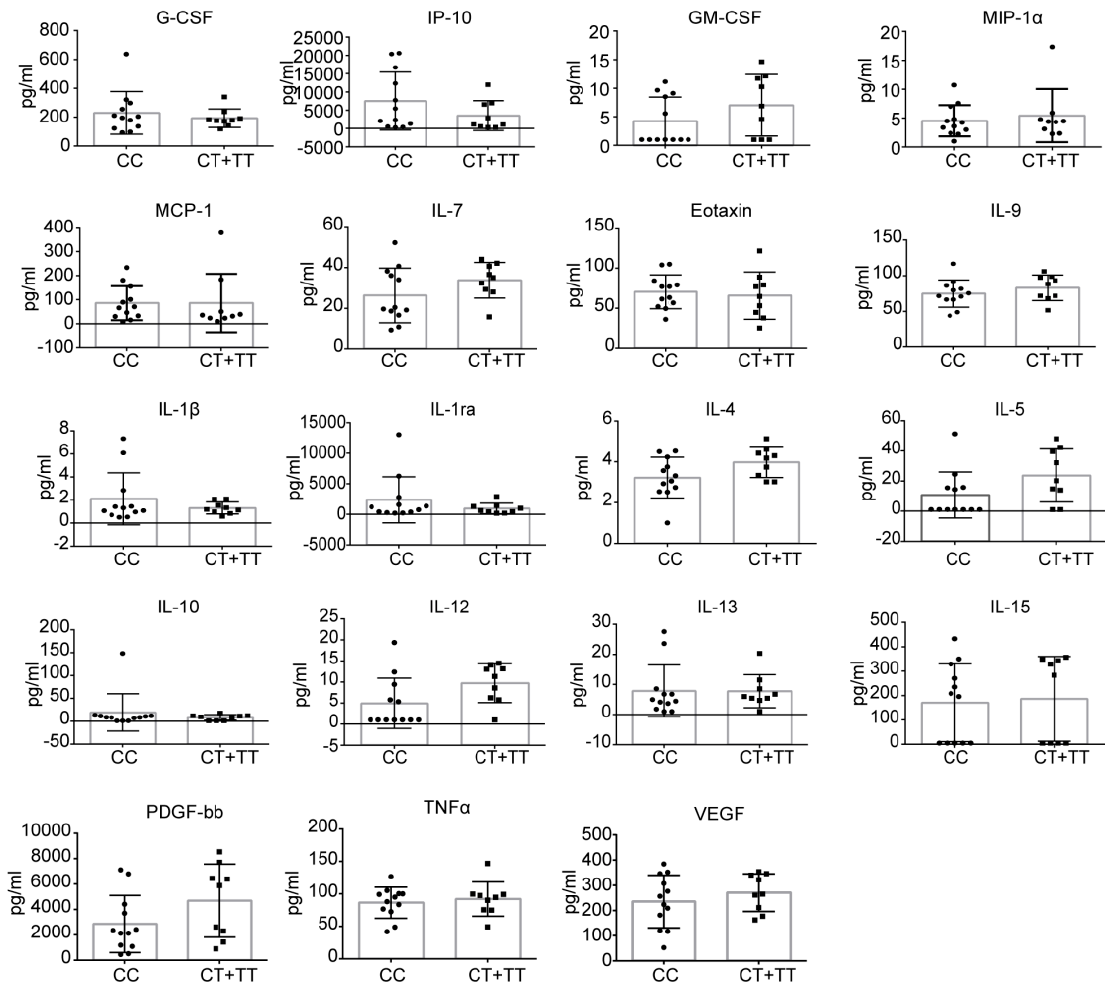
Figure 5. Levels of cytokines and chemokines in COVID-19 patients with the CC genotype or the CT/TT genotypes. Statistically significant differences were observed for IL-2 ( p = 0.043), IL-17 ( p = 0.013), FGF-basic ( p = 0.034), and RANTES ( p = 0.034). *, p < 0.05.